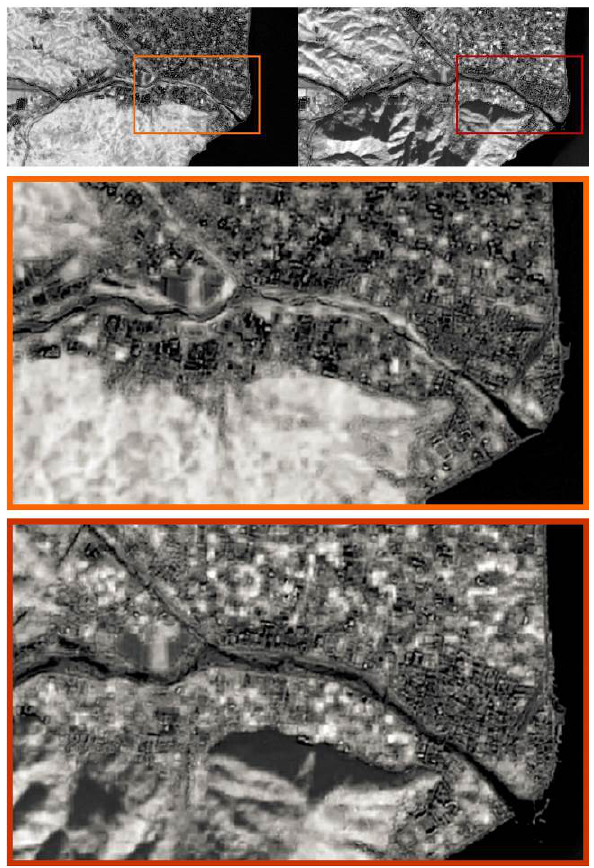
image were used to calculate the NDVI values of the case study area in months of May and in November, just after the flooding event (Figure 4).